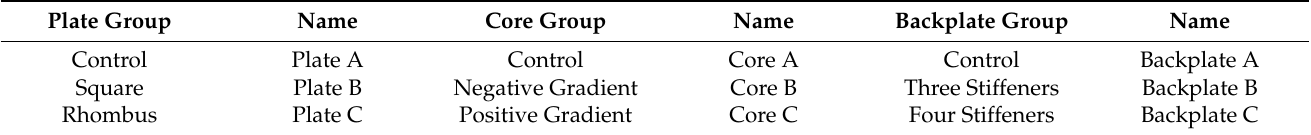
Table 1. The structure designed in this